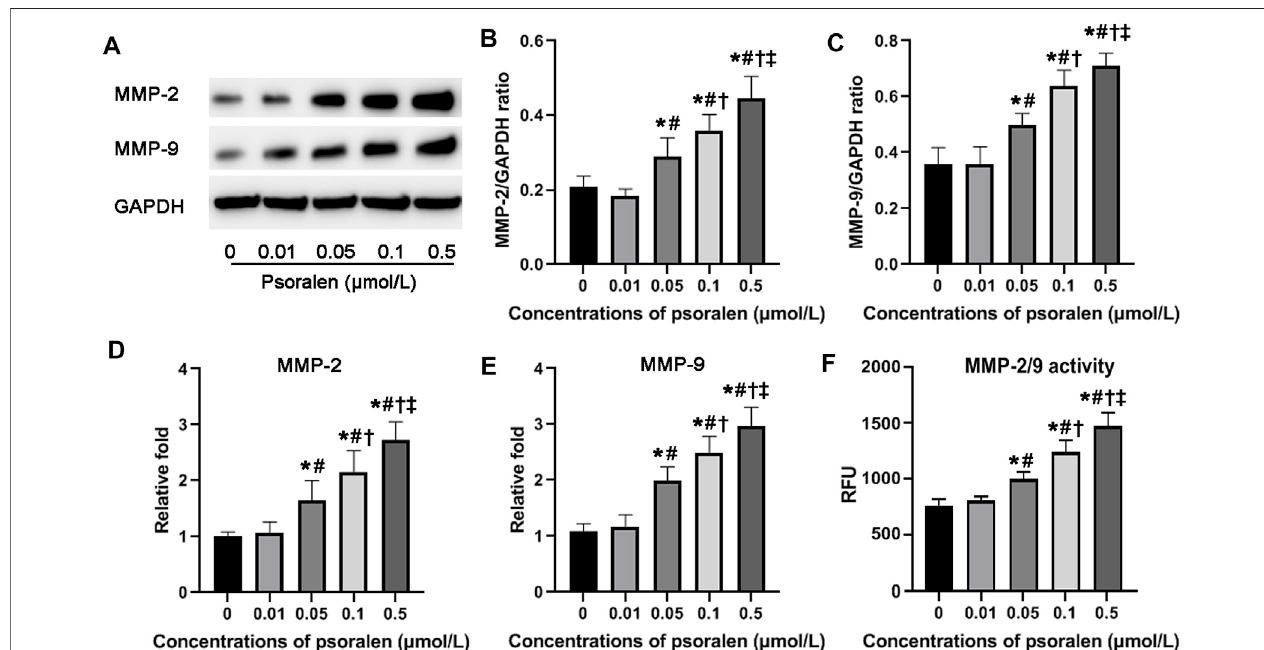
FIGURE 3 | Psoralen enhances both MMP-2 and MMP-9 expression and their activity of HTR-8/SVneo cells. (A) Representative images of Western blot. Relative protein levels of MMP-2 (B) and MMP-9 (C) after exposure to different concentrations (0, 0.01, 0.05, 0.1, and 0.5 μ mol/L) of psoralen for 48 h. Relative mRNA levels of MMP-2 (D) and MMP-9 (E) after exposure to different concentrations (0, 0.01, 0.05, 0.1, and 0.5 μ mol/L) of psoralen for 48 h. (F) Activity of MMP-2 and MMP-9 after exposure to different concentrations (0, 0.01, 0.05, 0.1, and 0.5 μ mol/L) of psoralen for 48 h. Values are mean ± SD. Experiments were performed in triplicate and repeated three times. * p < 0.05 vs. 0 μ mol/L; # p < 0.05 vs. 0.01 μ mol/L; † p < 0.05 vs. 0.05 μ mol/L; ‡ p < 0.05 vs. 0.1 μ